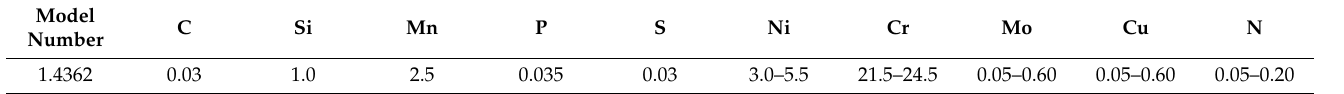
Table 1. Chemical composition mass fraction of duplex stainless steel bars (%).